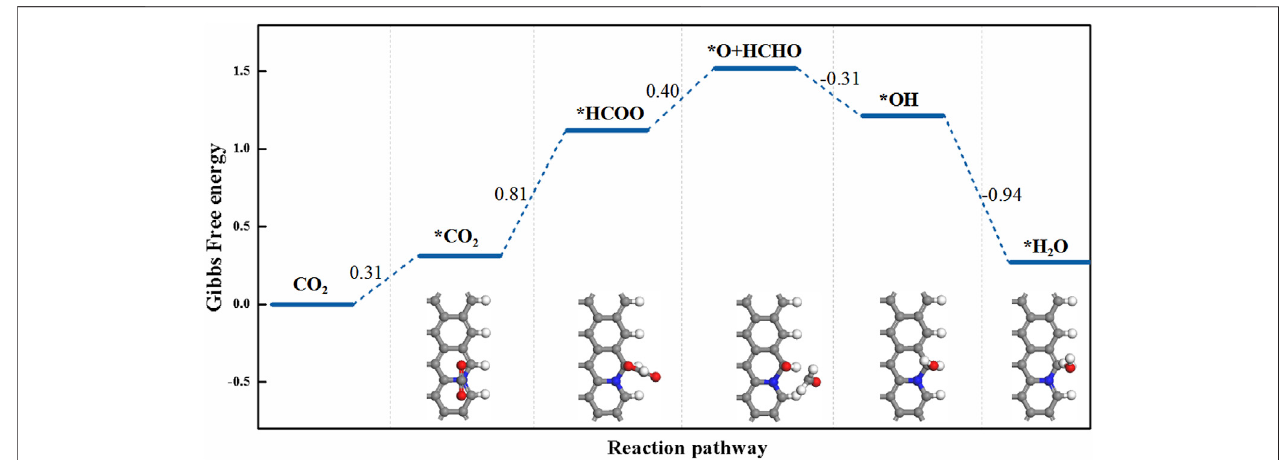
FIGURE 3 | The free energy change for the reaction of CO 2 + 4H + + 4e − → HCHO + H 2 O on Z-GN.